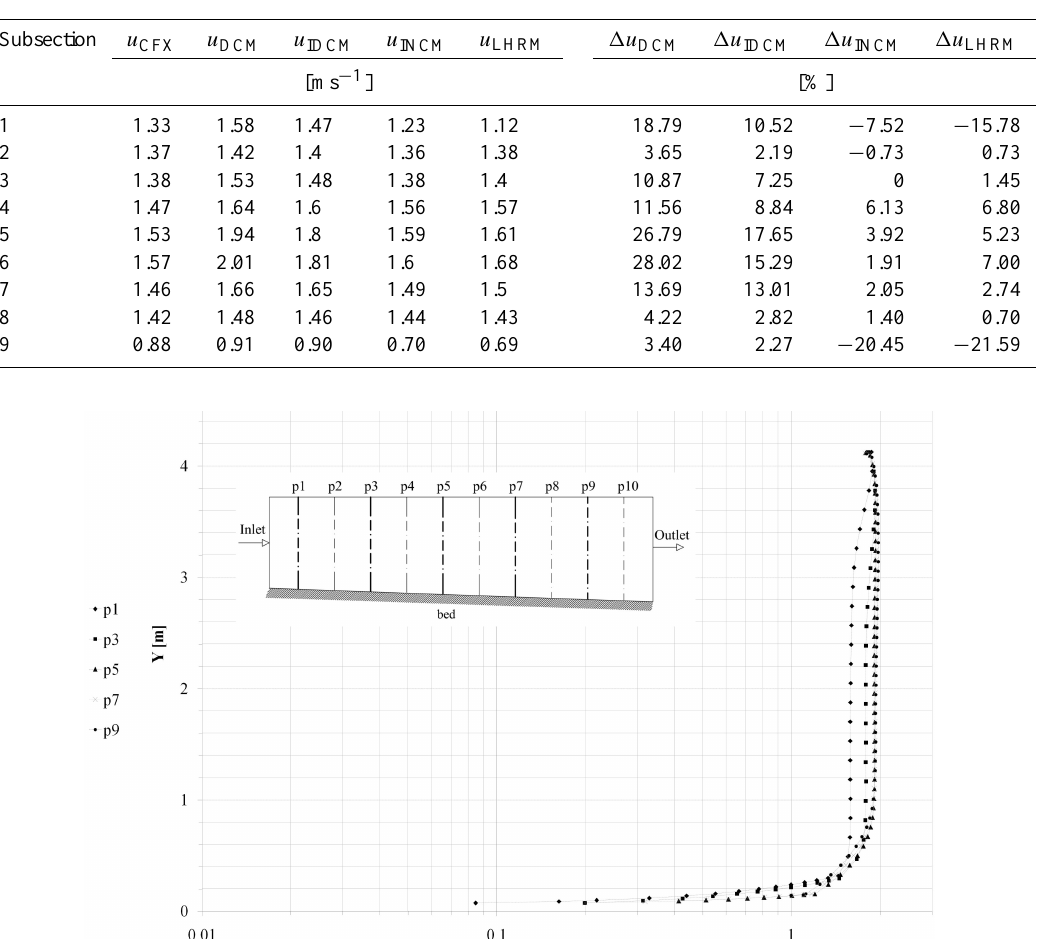
nents for 10 verticals equally spaced along the longitudinal axis of the main channel. See in Fig. 14 the plot of four of them and their locations. The streamwise velocity evolves longitudinally and becomes almost completely self-similar starting from the vertical line in the middle